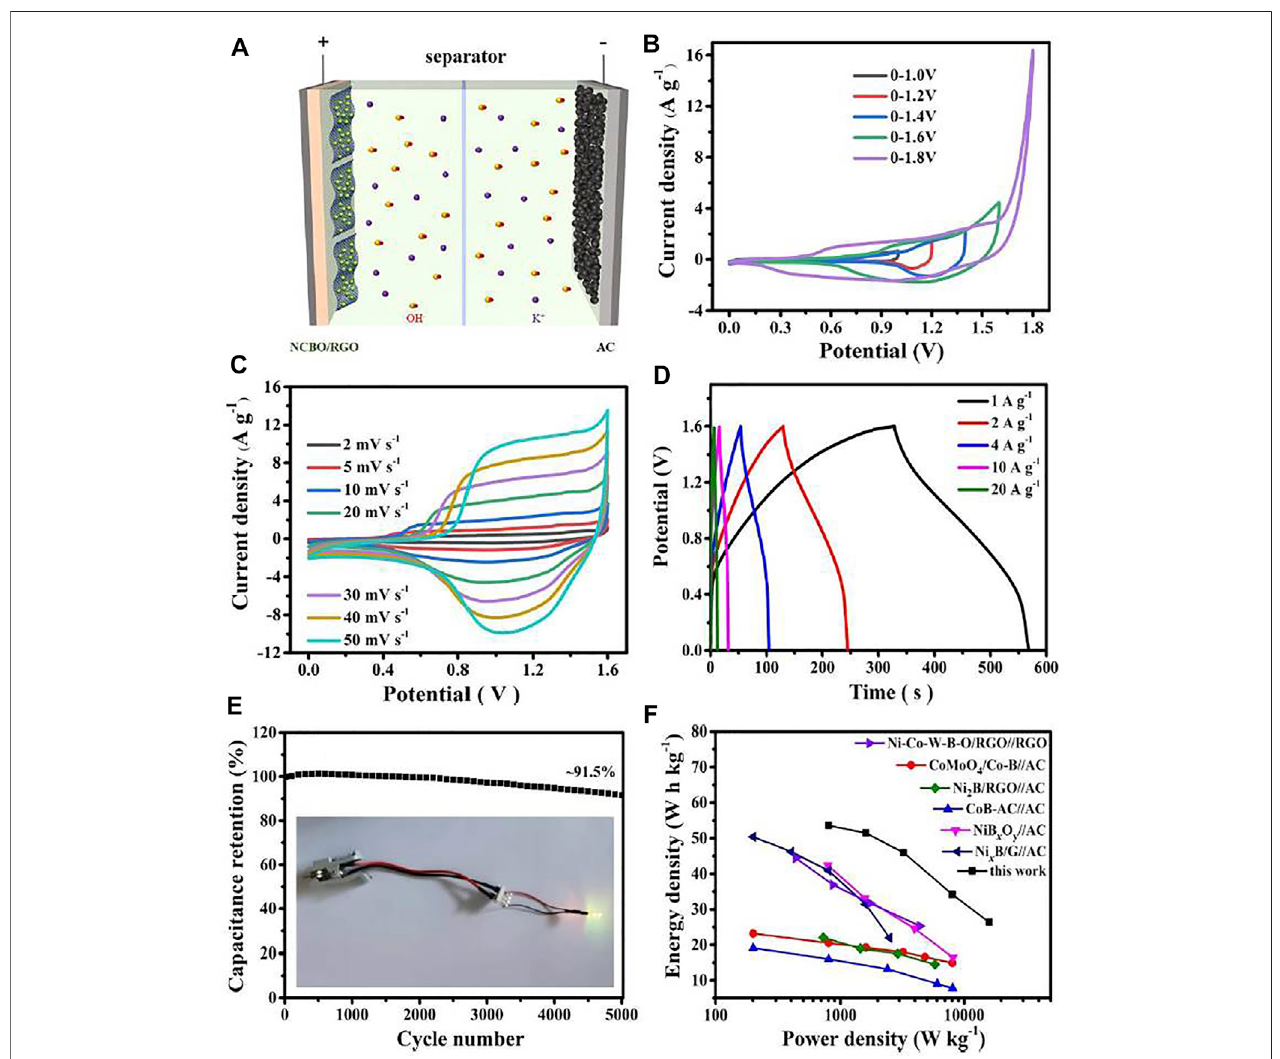
FIGURE 6 | (A) The electrochemical character of NCBO/RGO//AC asymmetric supercapacitor; (B) CV curves of NCBO/RGO//AC device test at different voltage windows(20 mV s − 1 ); (C) CVcurvesofNCBO/RGO//ACdeviceatvariousscanrates; (D) GCDcurvesofNCBO/RGO//ACdeviceatvariouscurrentdensities; (E) Long- term cycling test of NCBO/RGO//AC device at 2 A g − 1 (inset: photograph of a yellow LED lighted with two tandem NCBO/RGO//AC asymmetric supercapacitors); (F) Ragone plot of NCBO/RGO//AC device compared with other literatures.